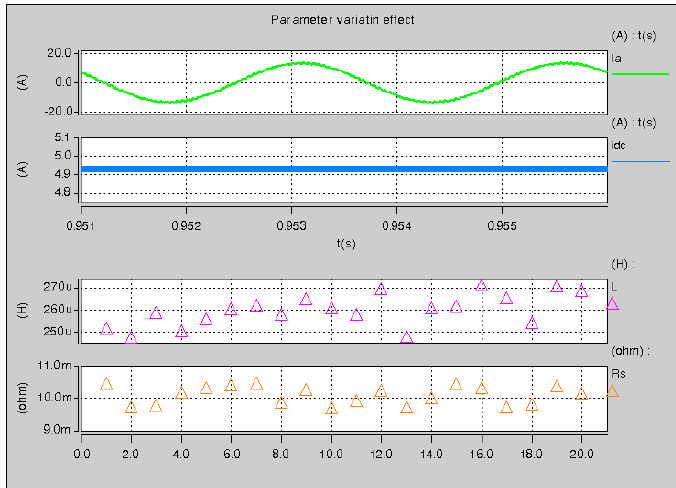
Figure 15. Parameter variation for the robustness analysis.